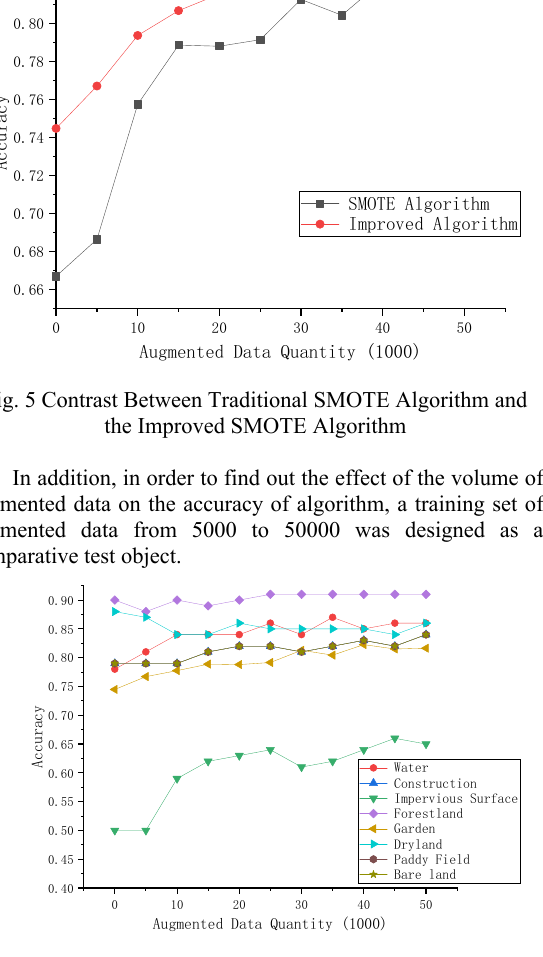
Fig. 6 Change of Accuracy with Different Volume of Augmented Data